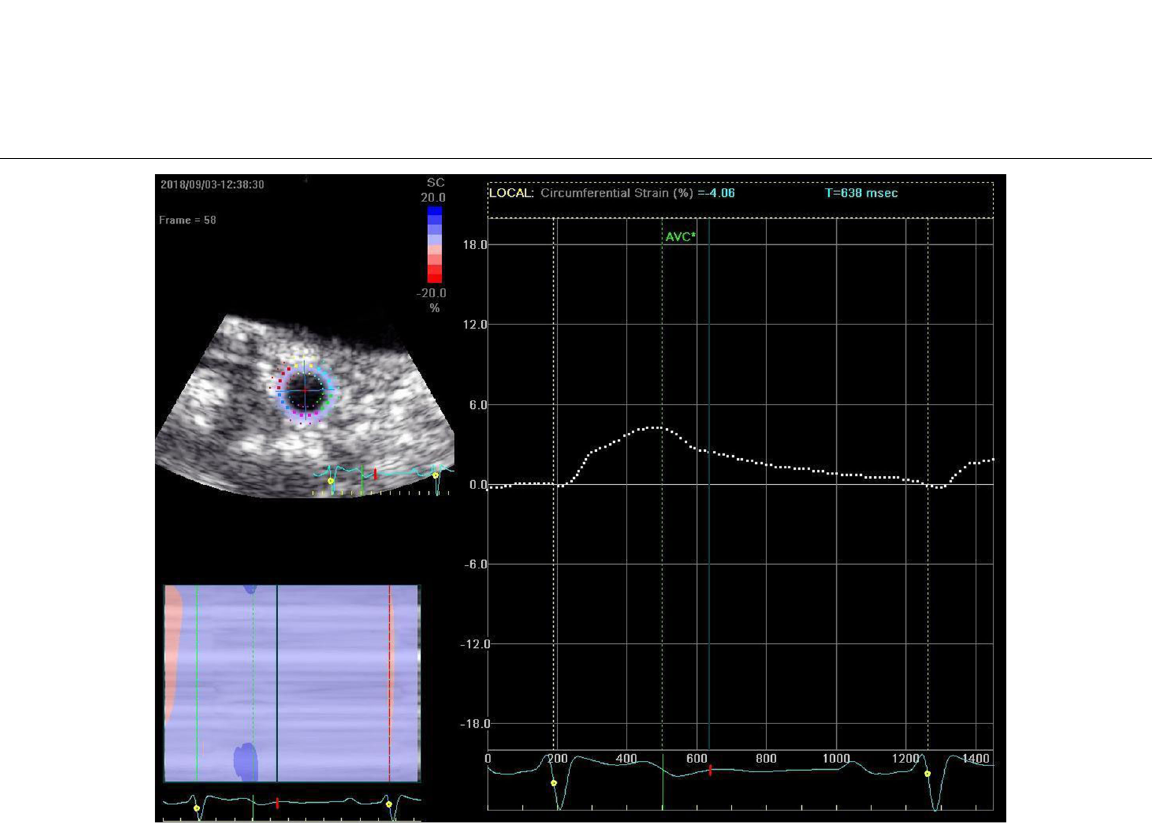
Fig. 4 Measurement of CS of a patient with DN by 2D-STE.The image was obtained from the short-axis view of the right common carotid